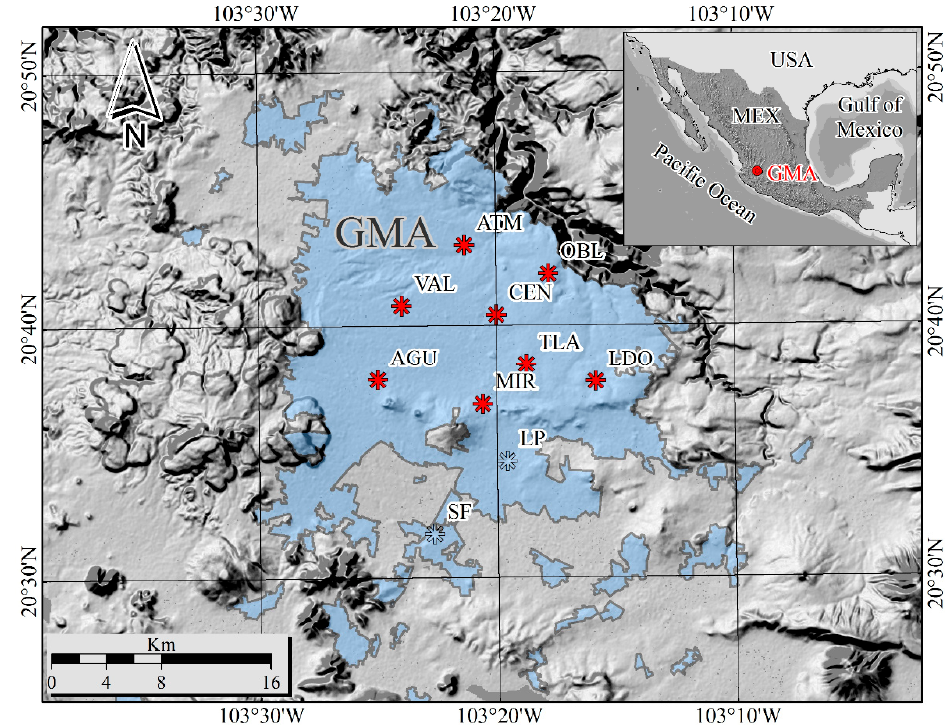
Figure 1. Map with the monitoring network in the Guadalajara Metropolitan Area (GMA). Empty locator: stations excluded by incomplete information for the analyzed period. Abbreviations: Las